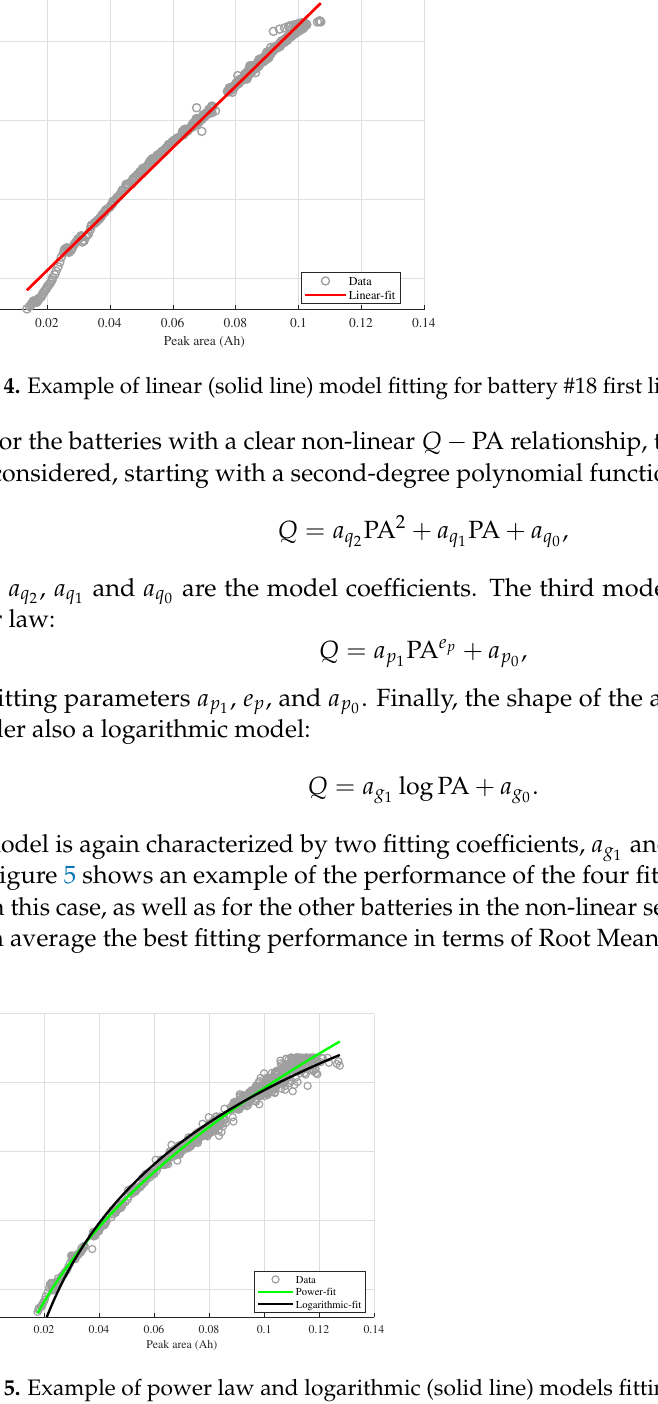
Figure 5. Example of power law and logarithmic (solid line) models fitting for battery #42 first life data